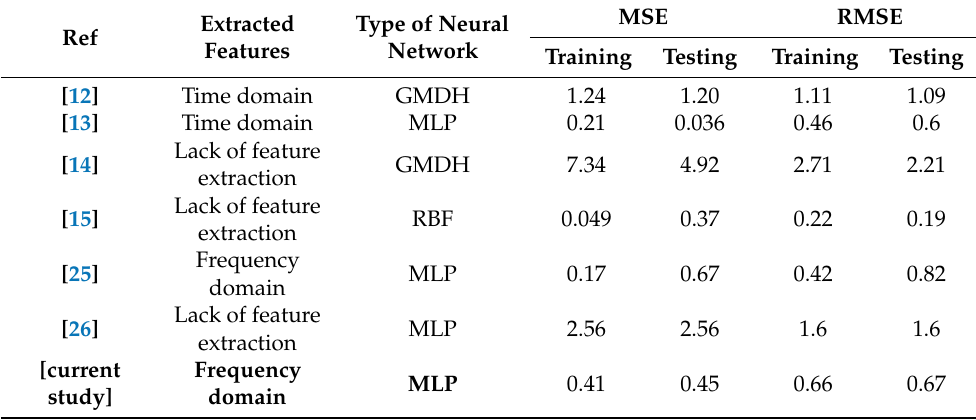
Table 3. The accuracy of the presented detection system compared to previous